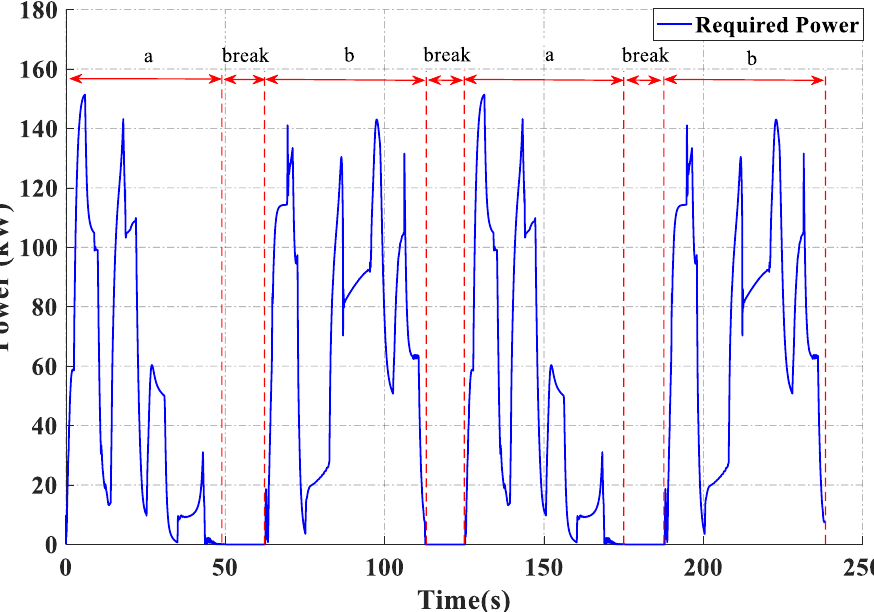
Figure 15. Required power of the excavator with two different working cycles.